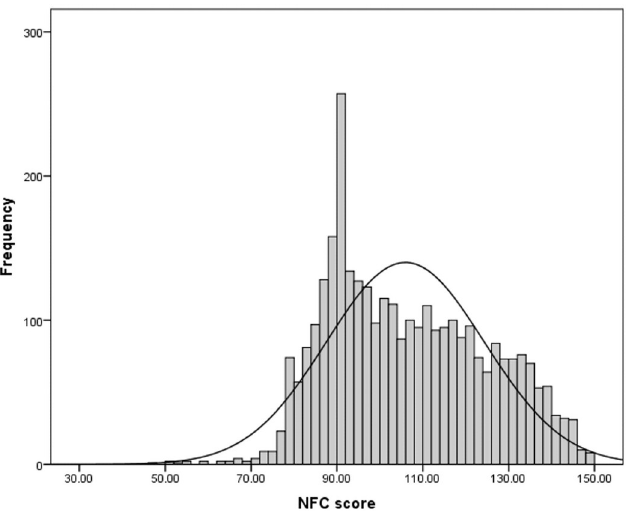
Fig 1. Distribution of NFC